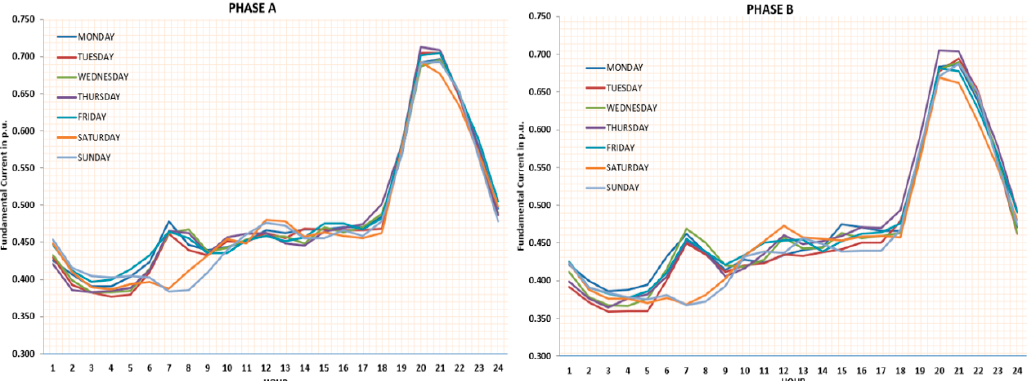
Figure 2. Hourly demand graphs of the fundamental effective currents.